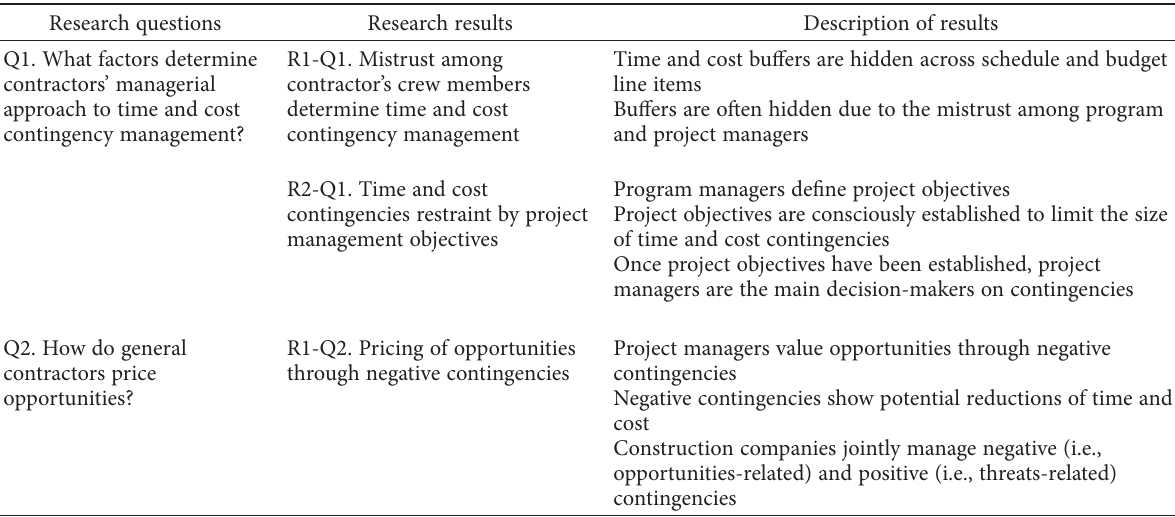
Table 4. Summary of results of the